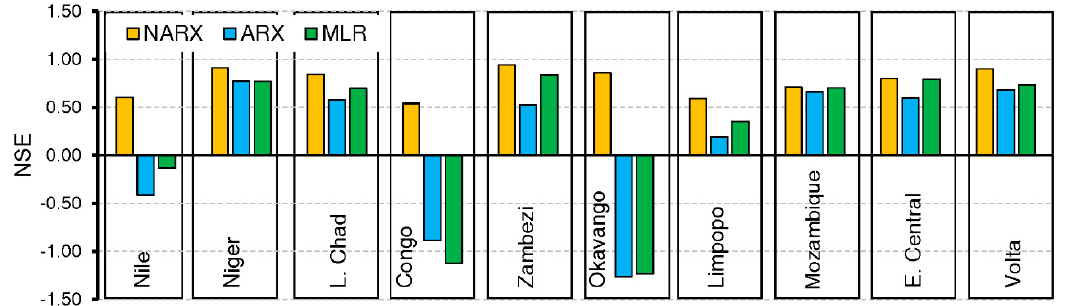
Figure 5. Performance of nonlinear autoregressive with exogenous input (NARX), nonlinear autoregressive exogenous (ARX), and multilinear regression (MLR) models over the investigated African watersheds.